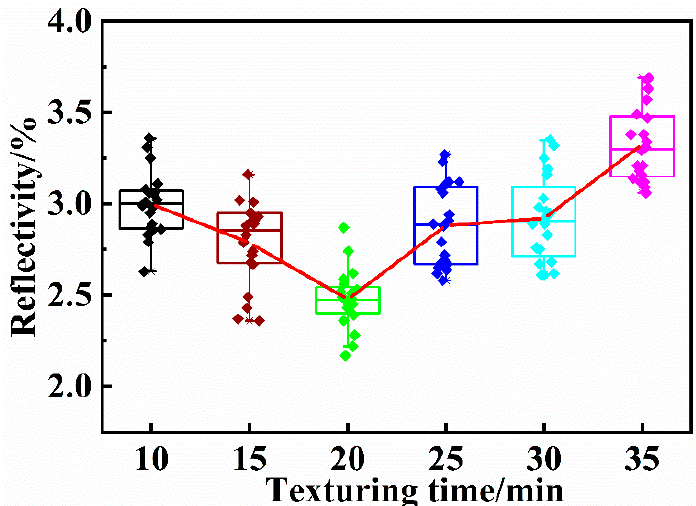
Figure 7. Reflectivity of the wafers. (the reflectivity and S h appear to first decrease and then increase with increasing texturing